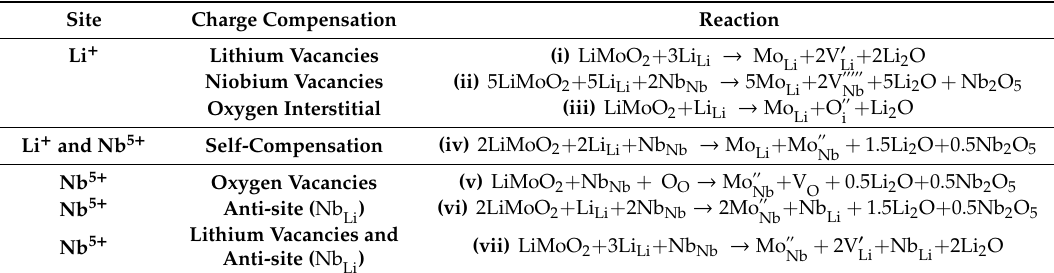
Table 5. Types of defects considered due to Mo 3 + incorporation in LiNbO 3 .